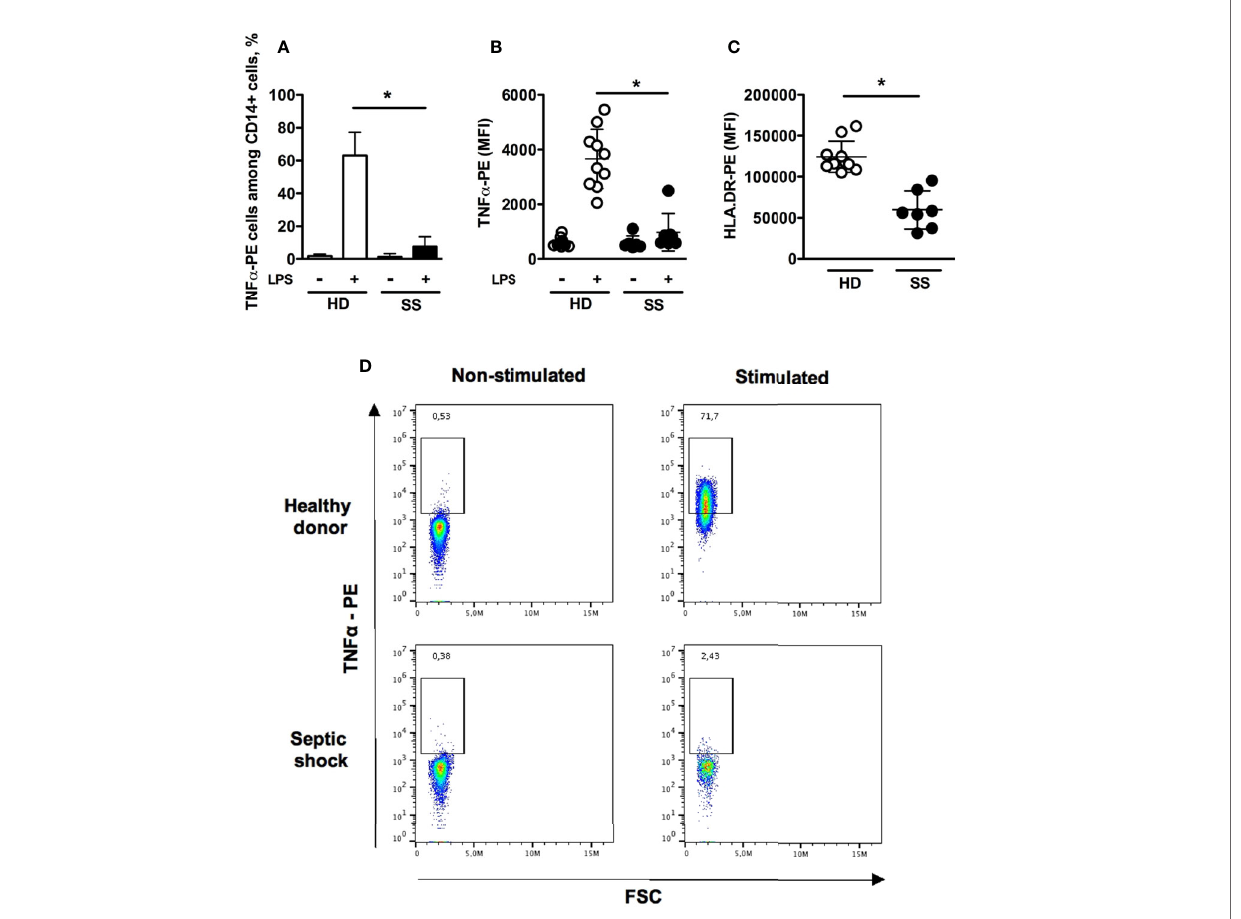
FIGURE 1 | Flow cytometry assessment of monocyte deactivation. Monocytes were stimulated in vitro with 1 m g/mL LPS for 180 minutes. (A) Proportions of TNF a - positive monocytes without or with LPS stimulation in healthy donors (n = 10) and septic shock patients (n=7). (B, C) TNF a intracellular staining (with or without LPS stimulation) and HLA-DR membrane expression. (D) Representative dot-plots of intracellular production of TNF a . Data are expressed as mean and standard deviation. *p <